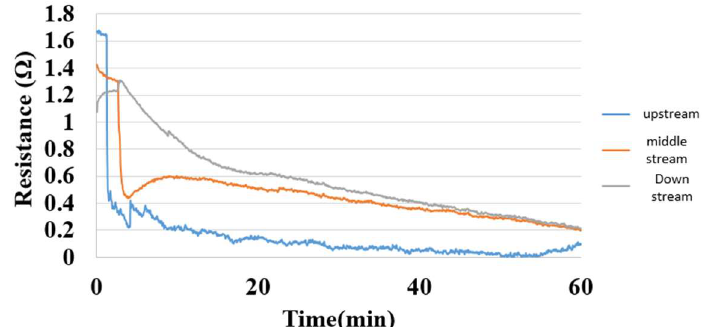
Figure 22. Hydrogen distribution inside the hydrogen end of the hydrogen/vanadium redox battery.